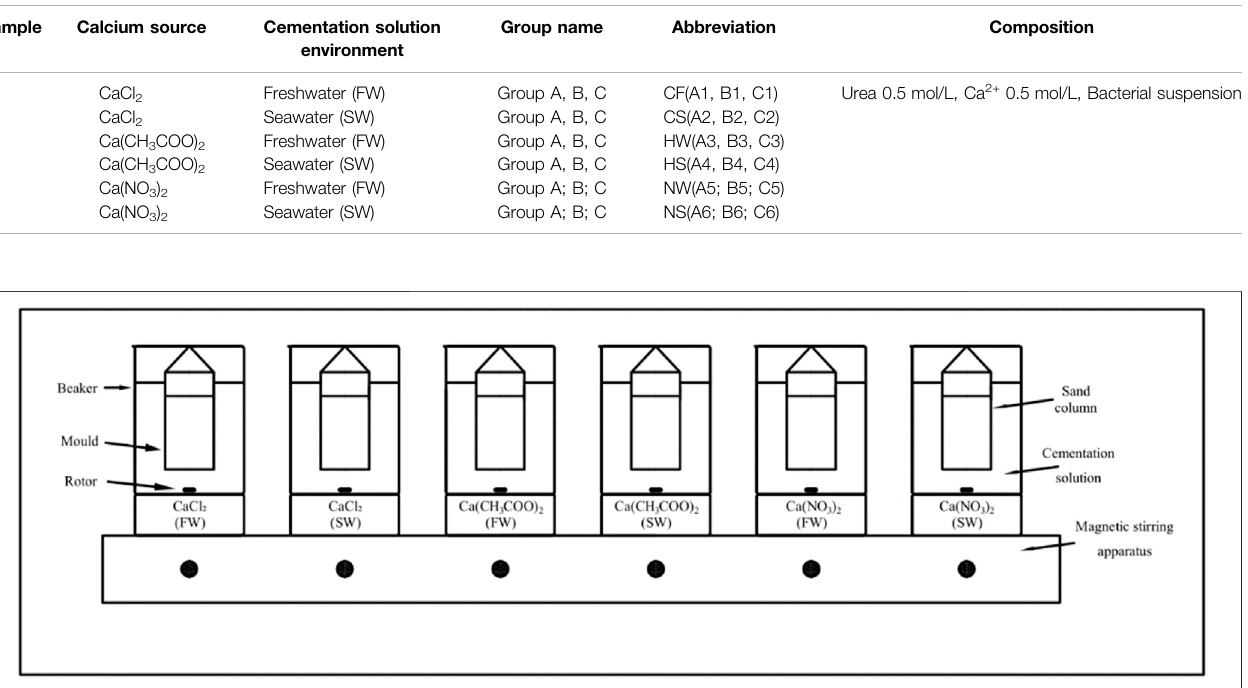
TABLE 1 | Composition of liquid medium for each group.